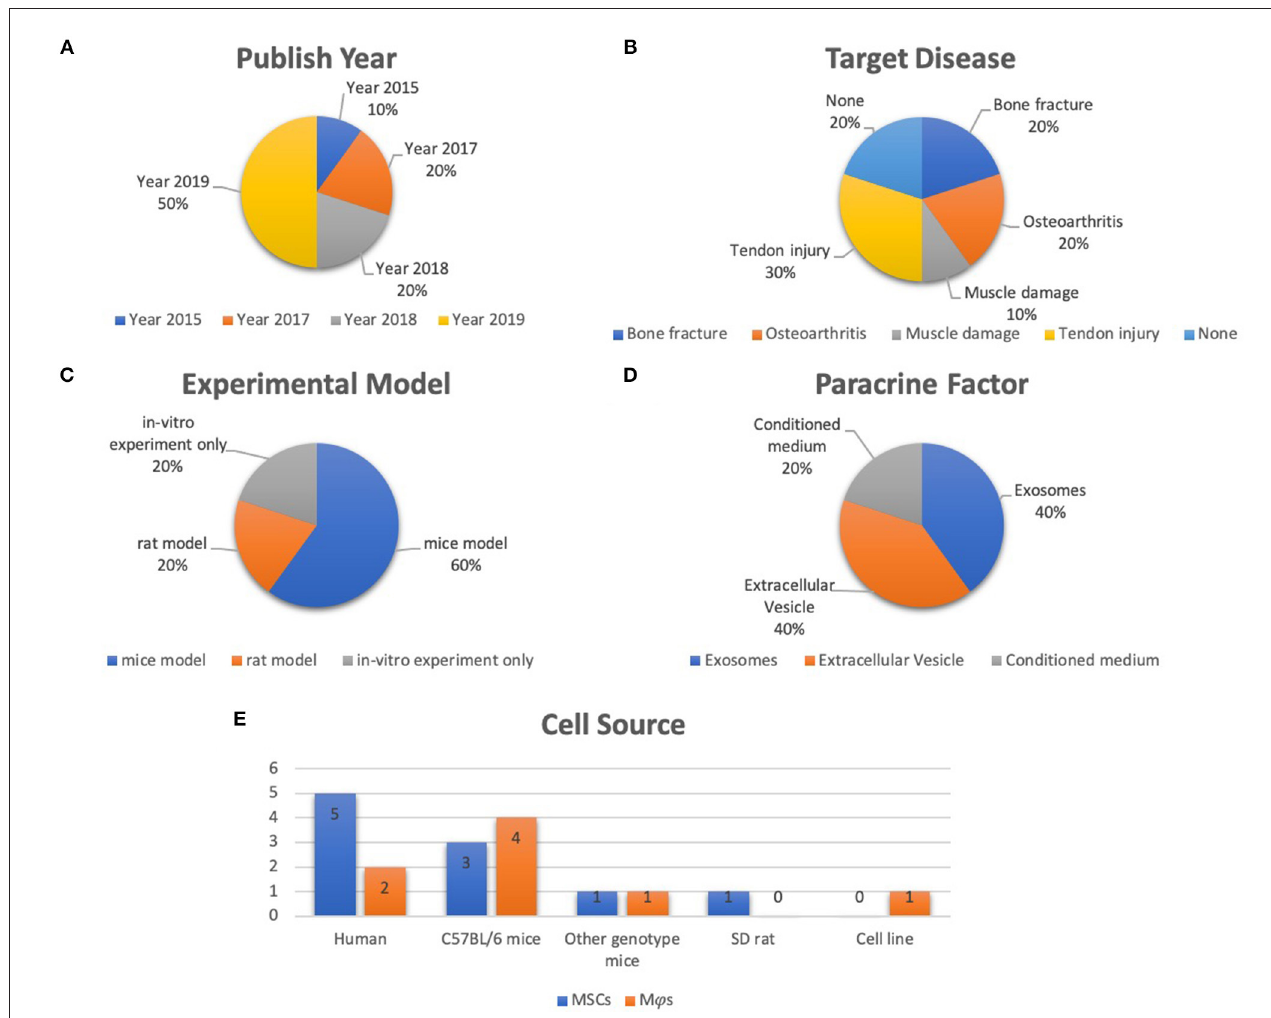
FIGURE 2 | Representative graph of the included studies presented in the articles reviewed. (A) Publication year of included studies (range from 2015 to 2020). (B) Target disease of included studies (include bone fracture, OA, muscle damage, tendon injury). (C) Experimental model of included studies (including mice model, rat model, in vitro experiment only). (D) Paracrine factors (including extracellular vesicle, exosomes, CM). (E) Cell source of included studies (including human, C57Bl/6 mice, other genotype mice, SD rat, cell